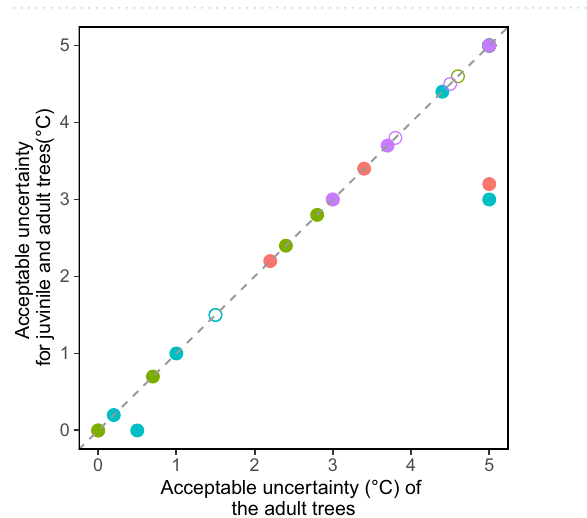
Figure 7. Effects of conservation of juvenile trees (5–10 cm DBH) on acceptable uncertainty in TM MAT for species richness maintenance. The x -axis indicates acceptable uncertainty for communities of trees with > 10 cm DBH, and the y -axis indicates that for communities including both adult and juvenile trees. Point color and shape correspond to the forest types and ages (see Fig. 3).